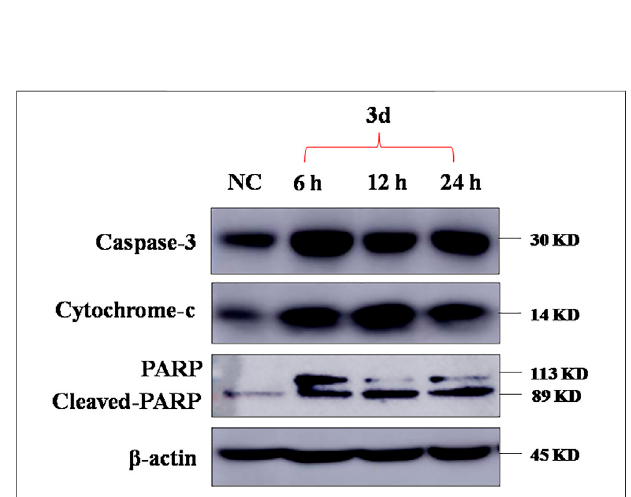
FIGURE 5 | Apoptosis-associated protein changes induced by 3d in